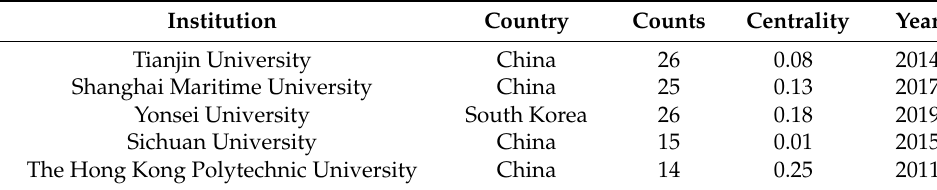
Table 1. Productive organizations and countries (top